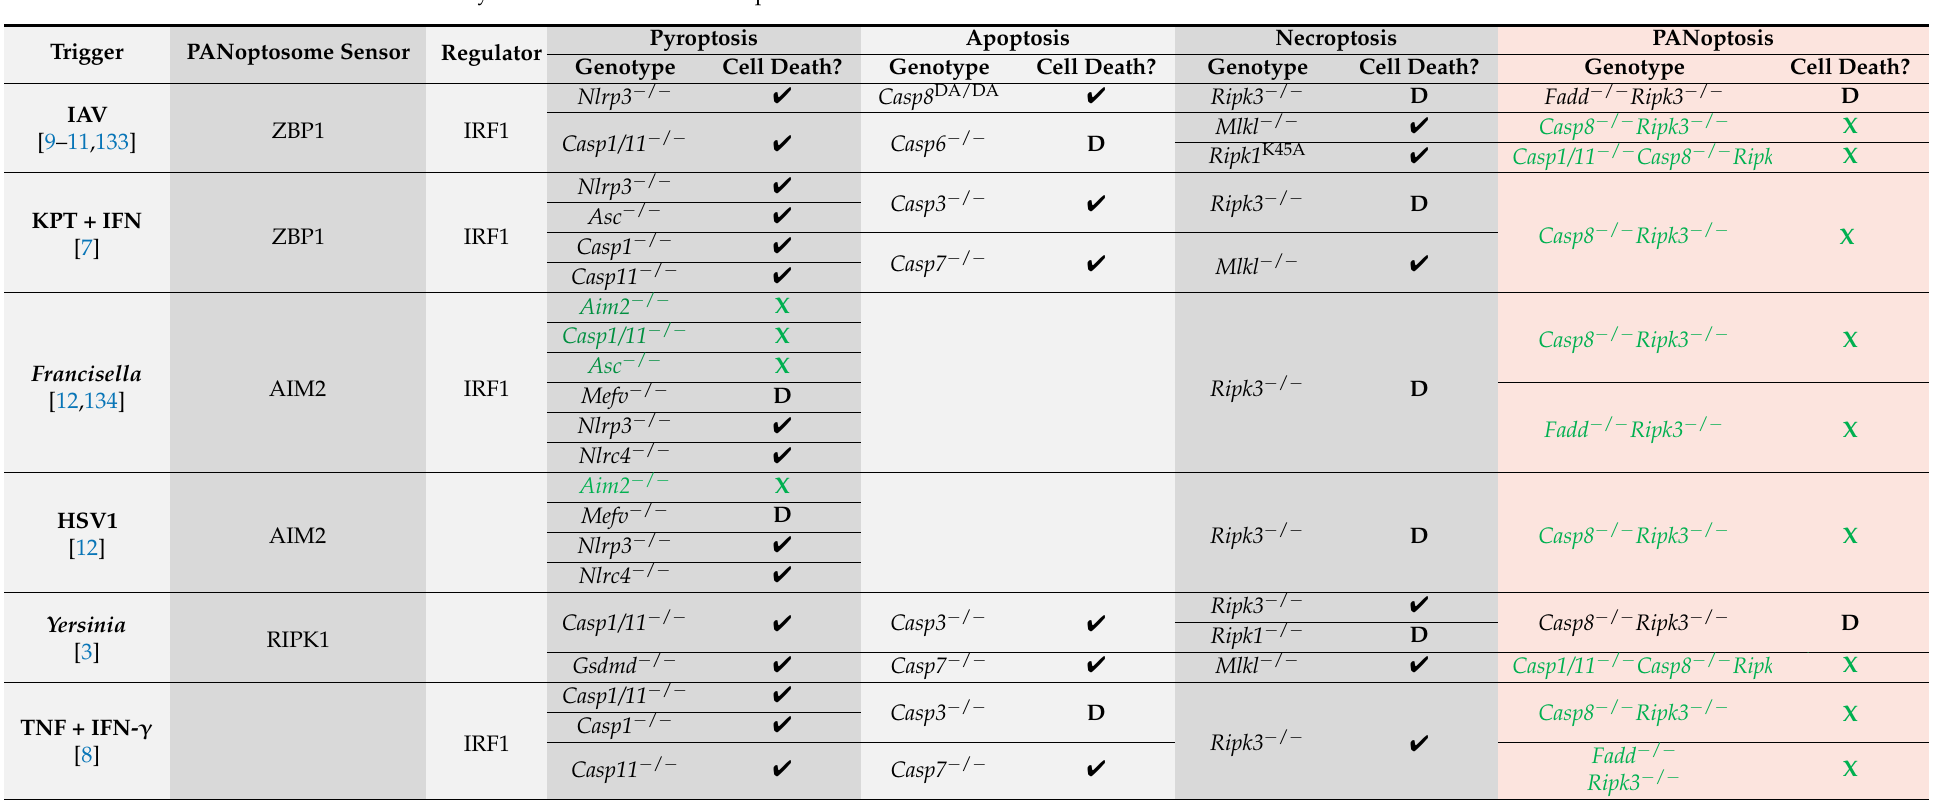
Table 1. Totality of cell death in cellular